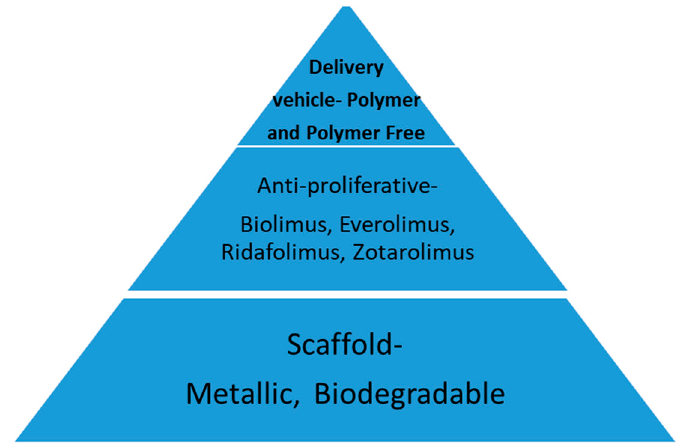
Figure 1. Schematic of components of coronary stent. Coronary stents are composed of a scaffold, delivery vehicle for anti-proliferative agent, and an anti-proliferative agent.